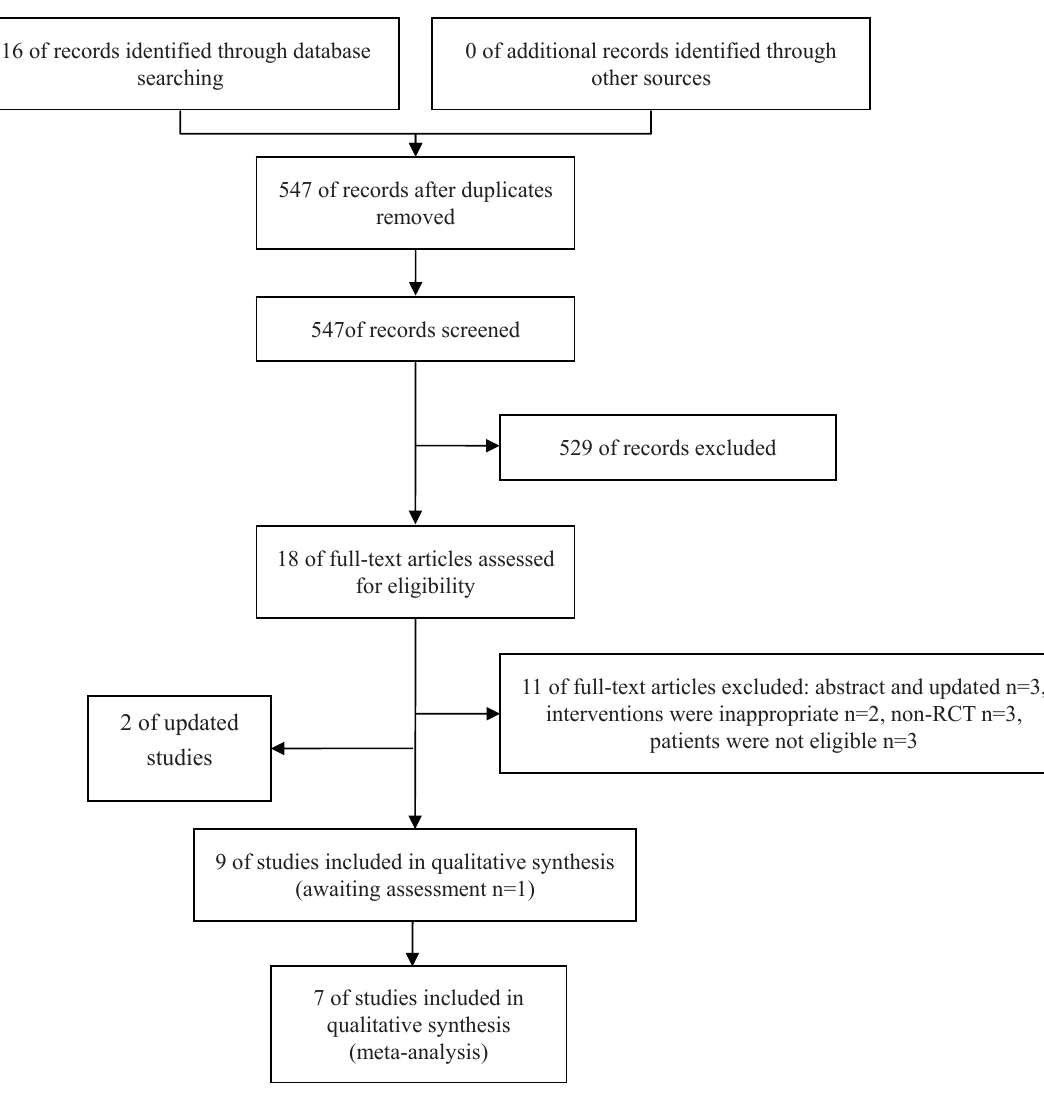
Figure 1 - The flowchart of literature